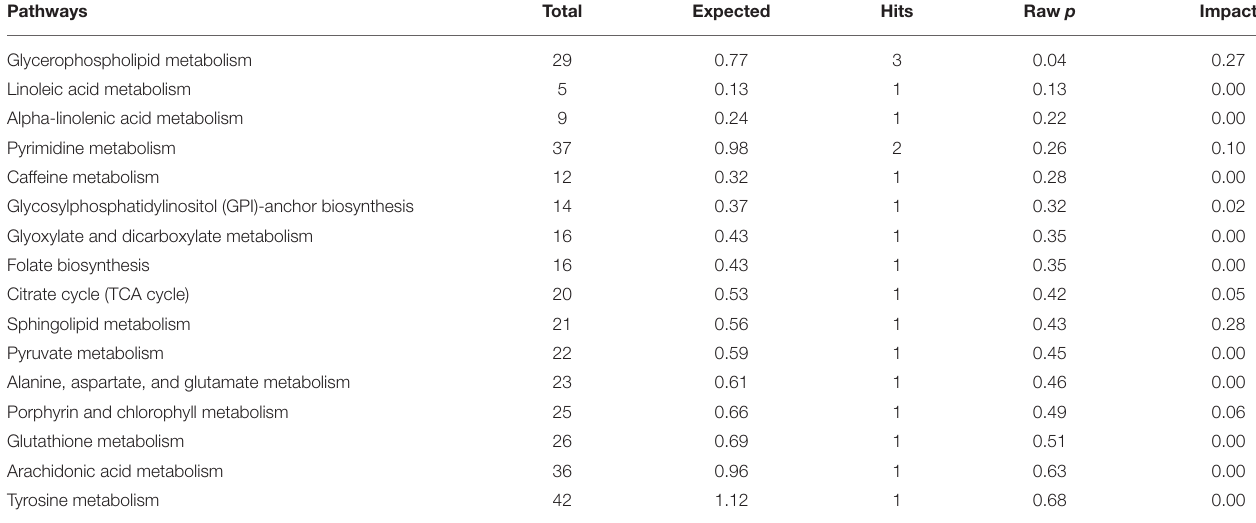
TABLE 2 | Enrichment of pathways involved in unique metabolites of spermatozoa in normozoospermia bulls. Pathways Total